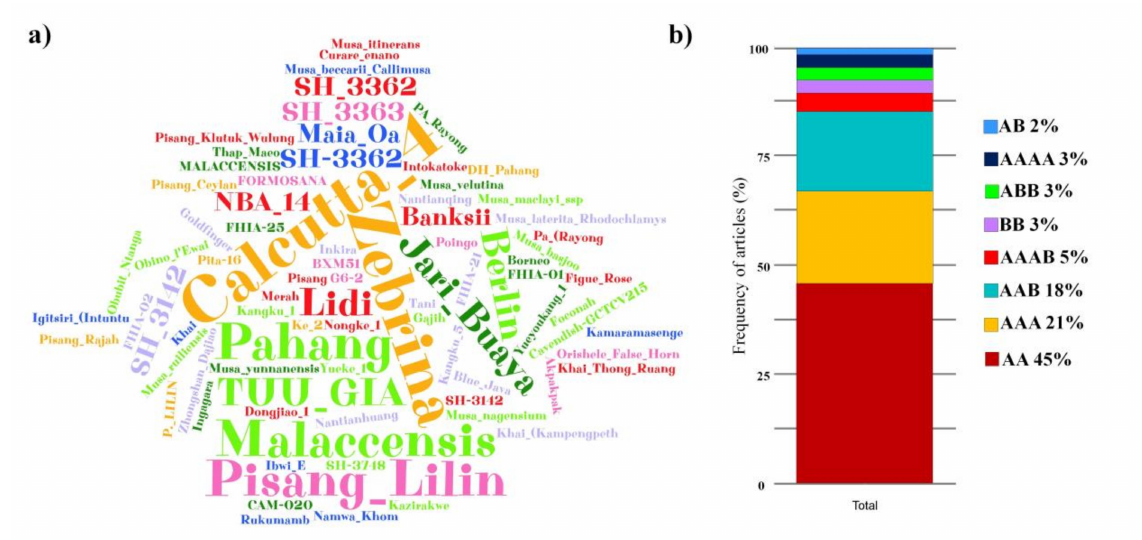
Figure 9. Sources of resistance to Fusarium oxysporum f. sp. cubense tropical race 4 (TR4) in studies on the improvement of banana plants to Fusarium wilt in the last ten years. ( a ) Word cloud of the frequency of cited sources of resistance. ( b ) Frequency of genomes related to the sources of resistance